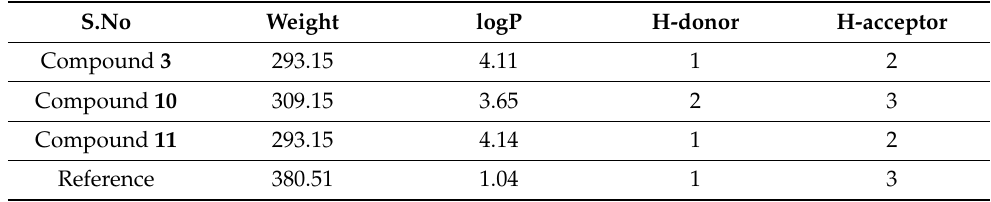
Table 1. Drug likeness of the most active